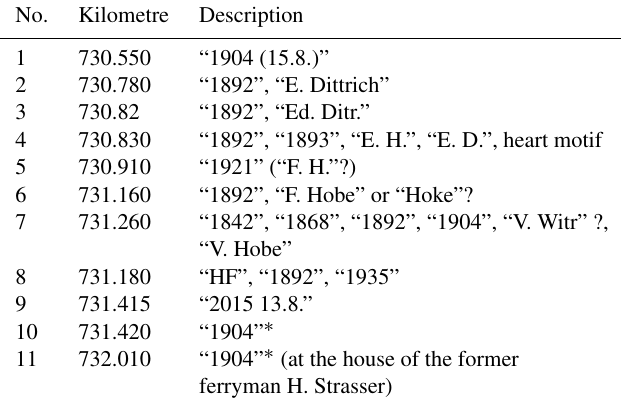
Table 6. Hunger stones detected in Dolní Žleb by Randák (2015, 2017a).